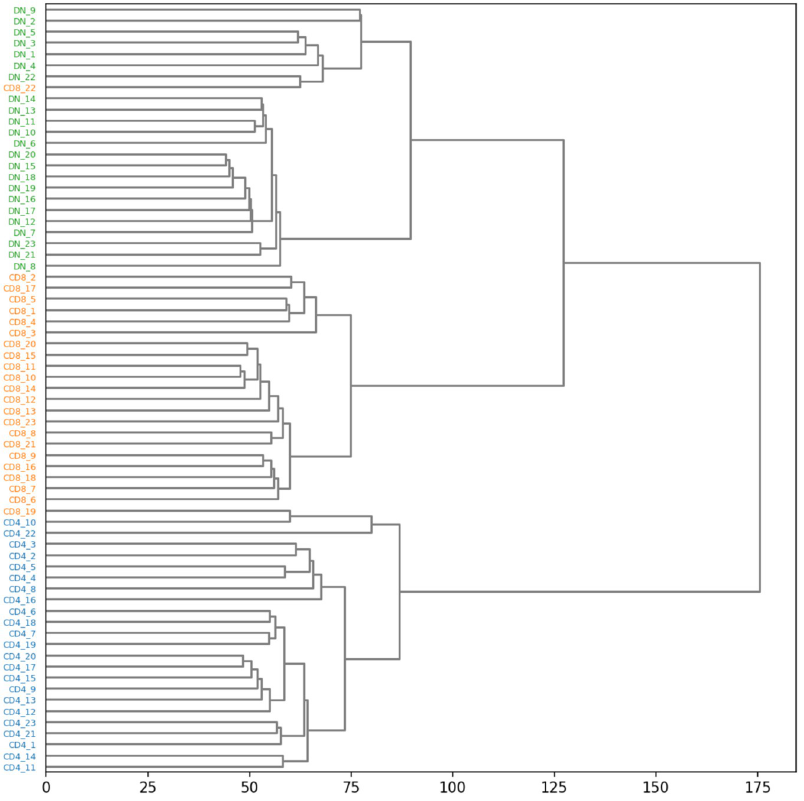
Fig 6. A hierarchical clustering tree built from the matrix of optimal transport repertoire distances, with the tips colored by the cell subpopulation: Green for DN, orange for CD8, and blue for CD4.